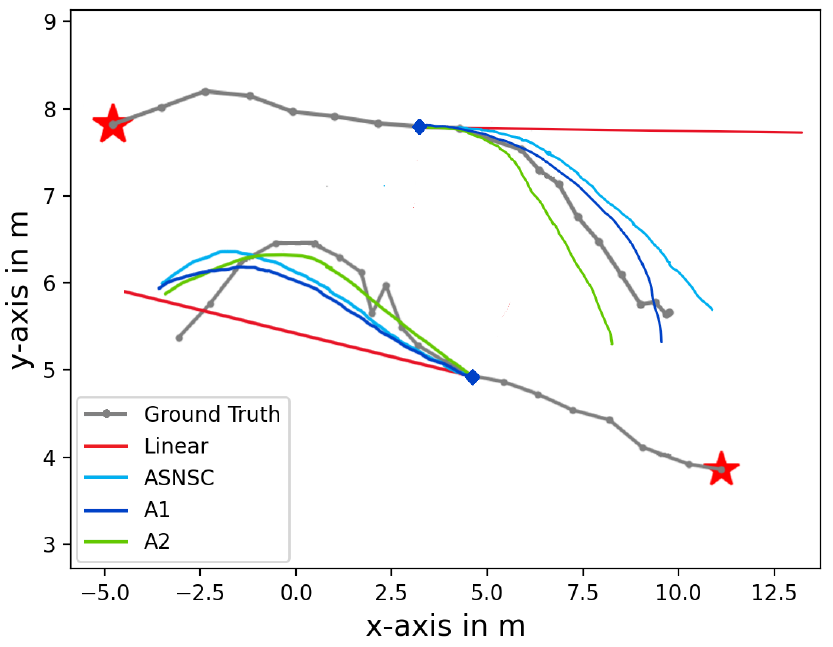
Figure 6. Two example trajectories from the ETH dataset and their predicted trajectories. (For interpretation of the line colors, the reader is referred to the web version of this